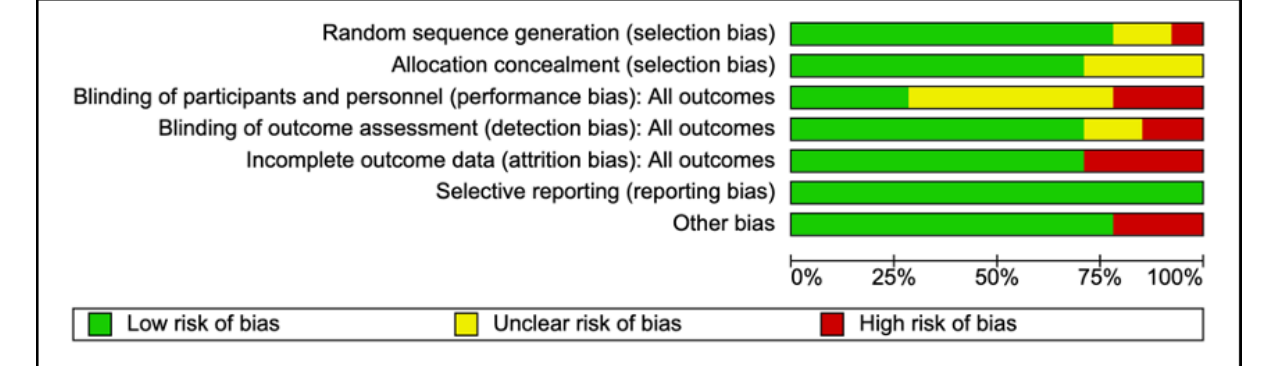
Figure 2. Risk of bias